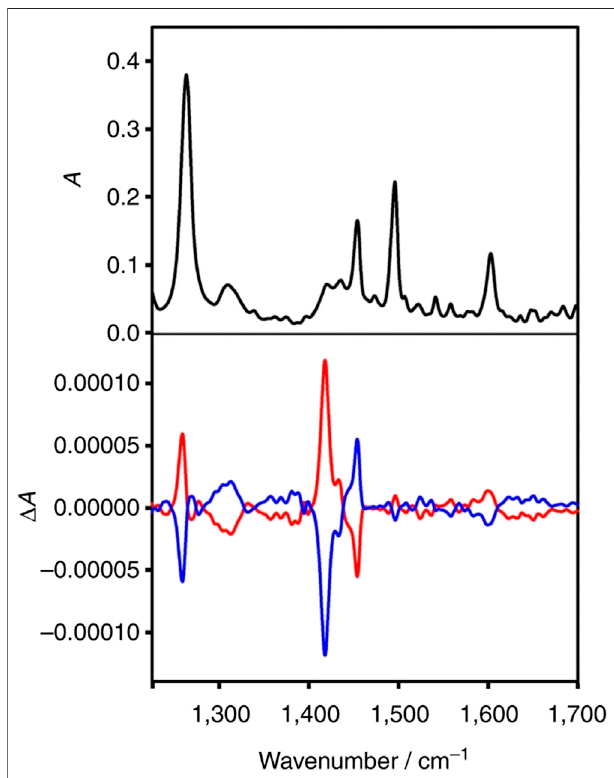
FIGURE 6 | Infrared spectrum of A-Au 38 (2-PET) 24 (black) and VCD spectra of enantiomer 1 (A-Au 38 (2-PET) 24 , red) and of enantiomer 2 (C-Au 38 (2-PET) 24 , blue). The fi gure and caption have been adapted with permission from Dolamic et al., (2015), Copyright & 2015 Macmillan Publishers